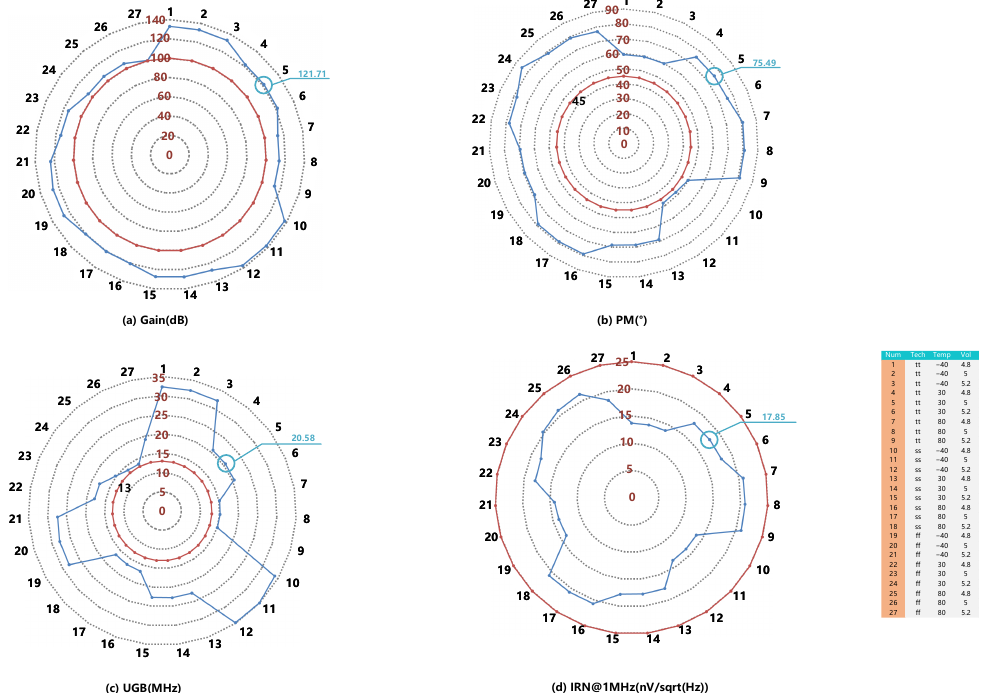
Figure 10. The PVT simulation result of ( a ) gain, ( b ) PM, ( c ) UGB, and ( d ) IRN of the opamp. Since the non-ideal factor of the second stage integrator can be shaped by the loop, the requirement of the second OTA can be significantly relaxed. The telescopic OTA is used to save power consumption. The schematic diagram and simulation results of the OTA are shown in Figure 11. The simulation results show that the gain of the second stage amplifier is greater than 60 dB and the gain bandwidth product is greater than 10 MHz.